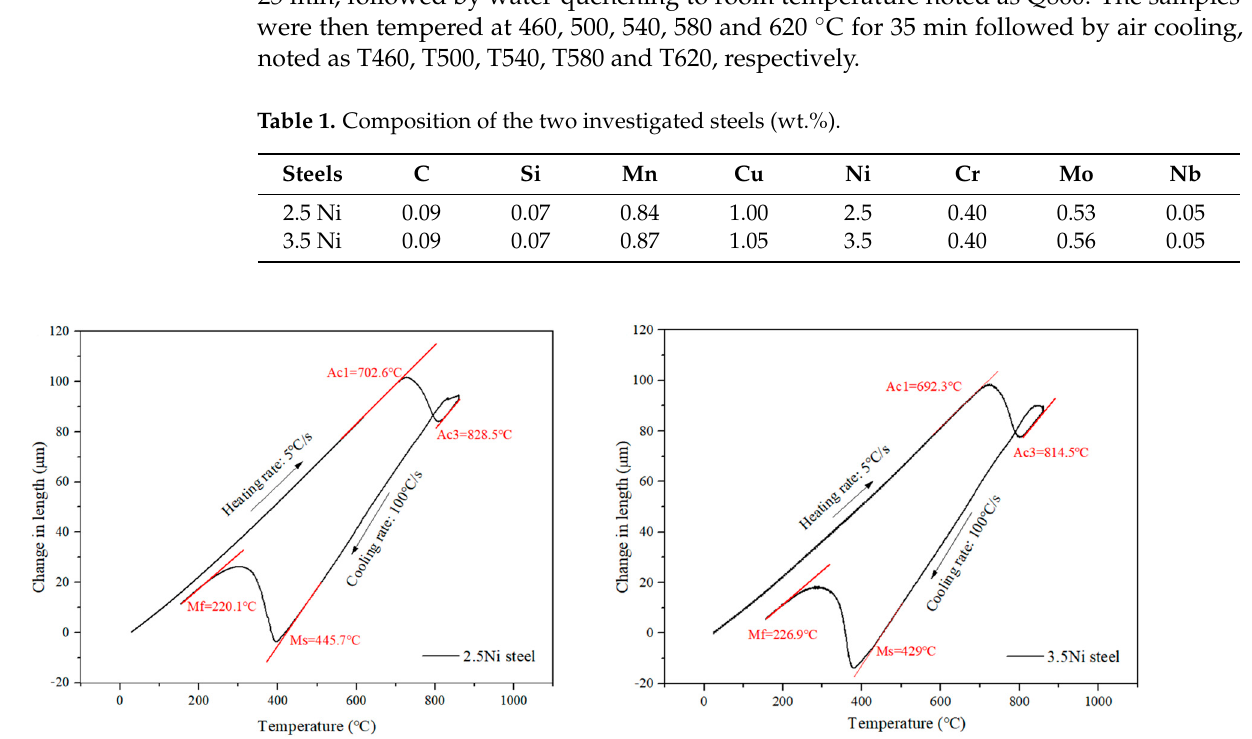
Figure 1. Dilatometric curve of the hot-rolled specimen for both steels.